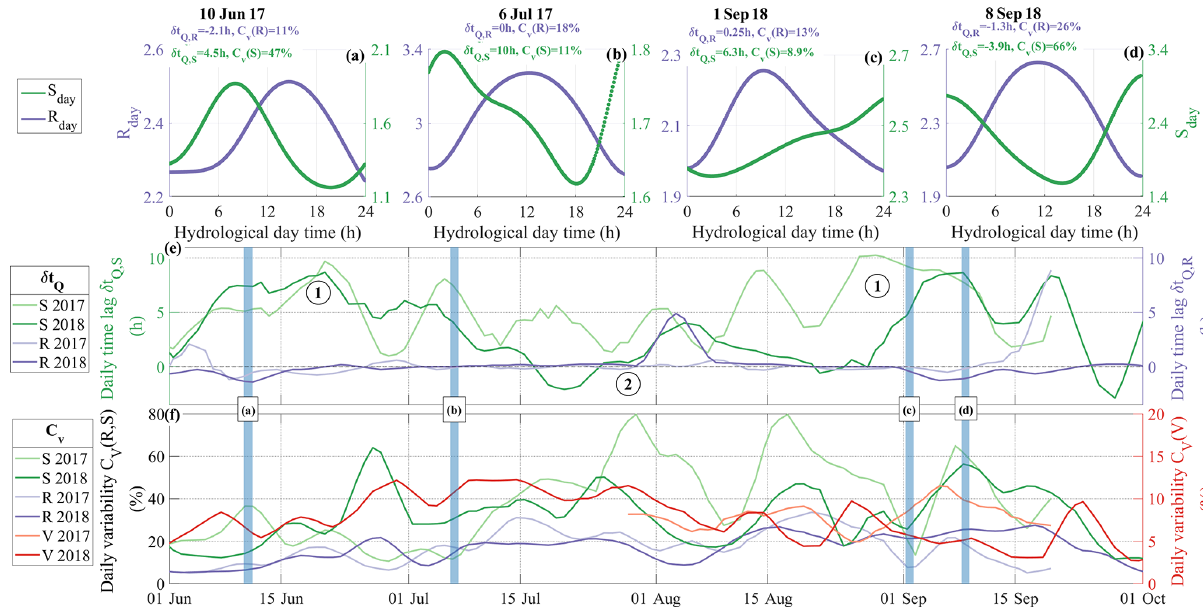
Figure 9. Diurnal evolution of the hydraulic radius R and hydraulic pressure gradient S and comparison to glacier dynamics. (a–d) Daily time series of R (purple line) and S (green line) for 4 selected hydrological days across the melt season. Time series are bandpass-filtered within 6–36h. Values of R day and S day are centred on the average respective absolute value of the corresponding day. Corresponding daily values of δt Q,R , δt Q,S , C v (R) and C v (S) are shown at the top of the panels. Note that y axis bounds differ from panel to panel. (e) Daily time lags δt Q,R between R day and Q day peaks (purple lines) and δt Q,S between S day and Q day peaks (green lines). (f) Sub-diurnal variability C v in R (purple lines), S (green lines) and the basal sliding speed V (red line). Time series are smoothed over 5d. Blue vertical bars show location of the 4 selected days with the corresponding panel. Shaded lines are data from 2017, and plain lines are data from 2018. Circled numbers refer to the two phases described in the main